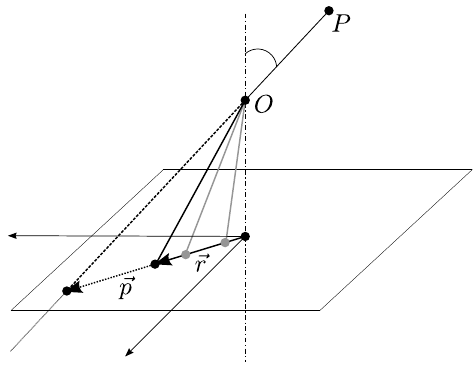
Figure 7: Radial alignment constraint